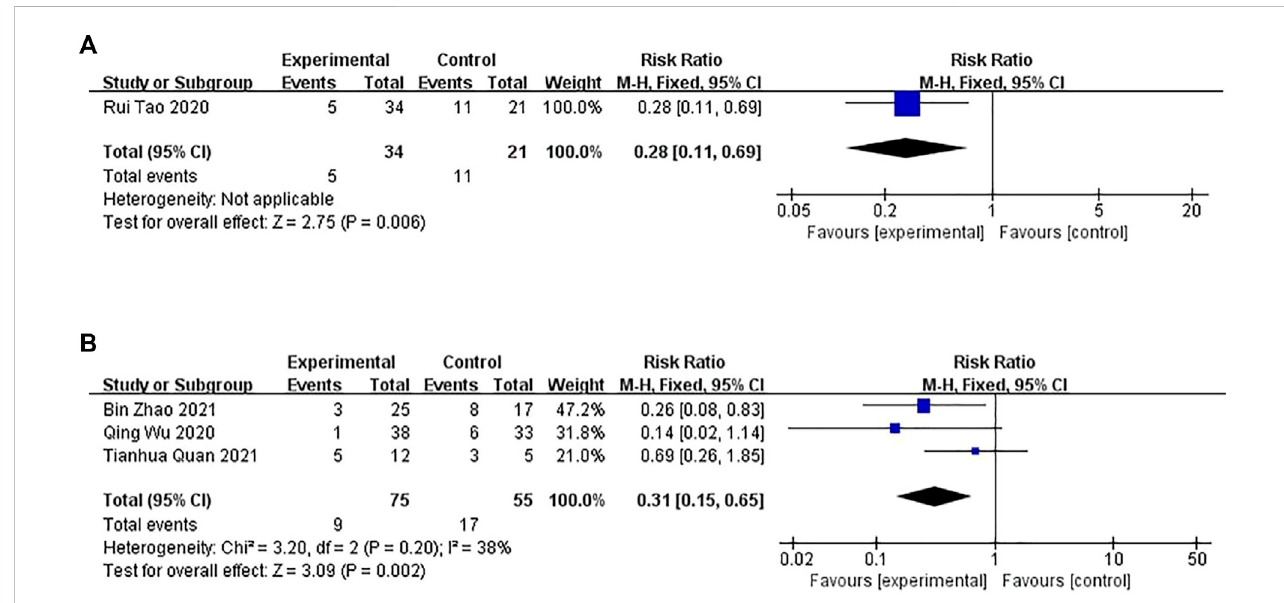
FIGURE 9 Theresultsofthemeta-analysisfortheeffectofChineseherbalmedicine(CHM)oracombinationofCHMandWesternmedicine(WM)versusWMonthe recurrence rate. (A) CHM versus WM; (B) Combination of CHM and WM versus